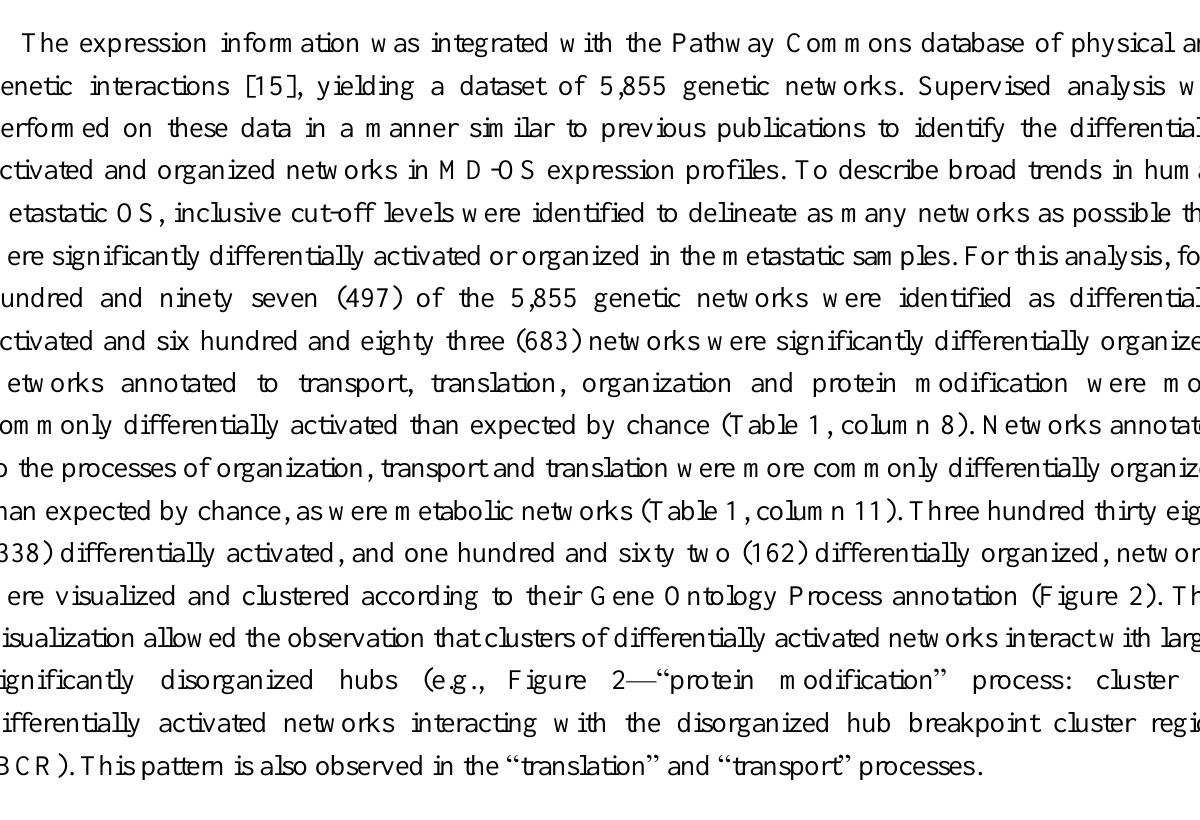
Figure 2—―protein modification‖ process: cluster of